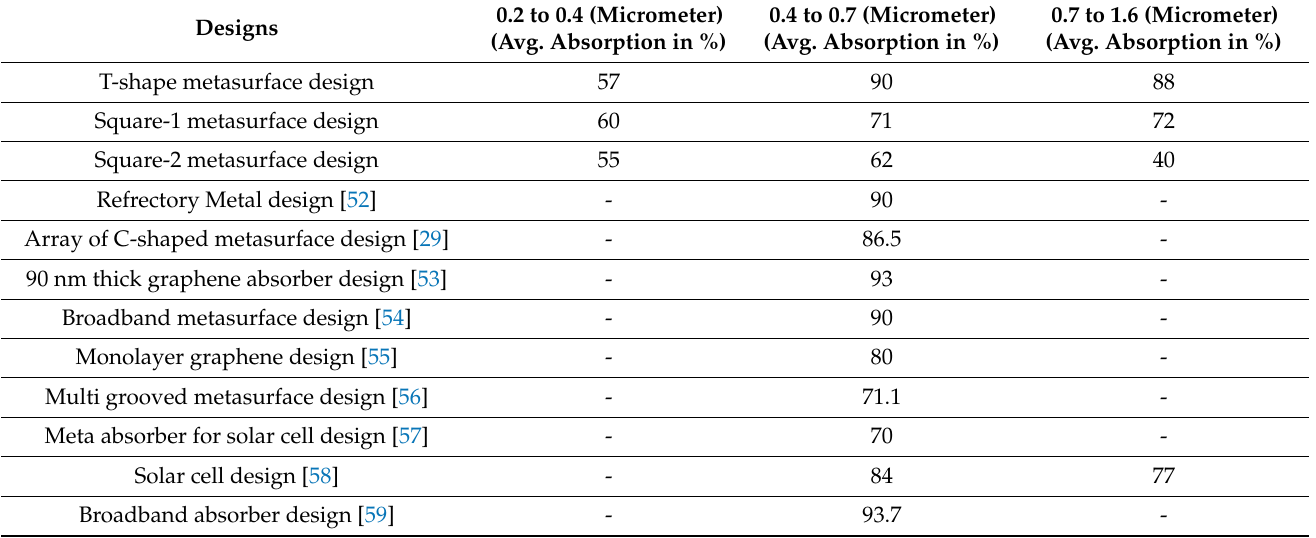
Table 2. The analysis of the three designs with other